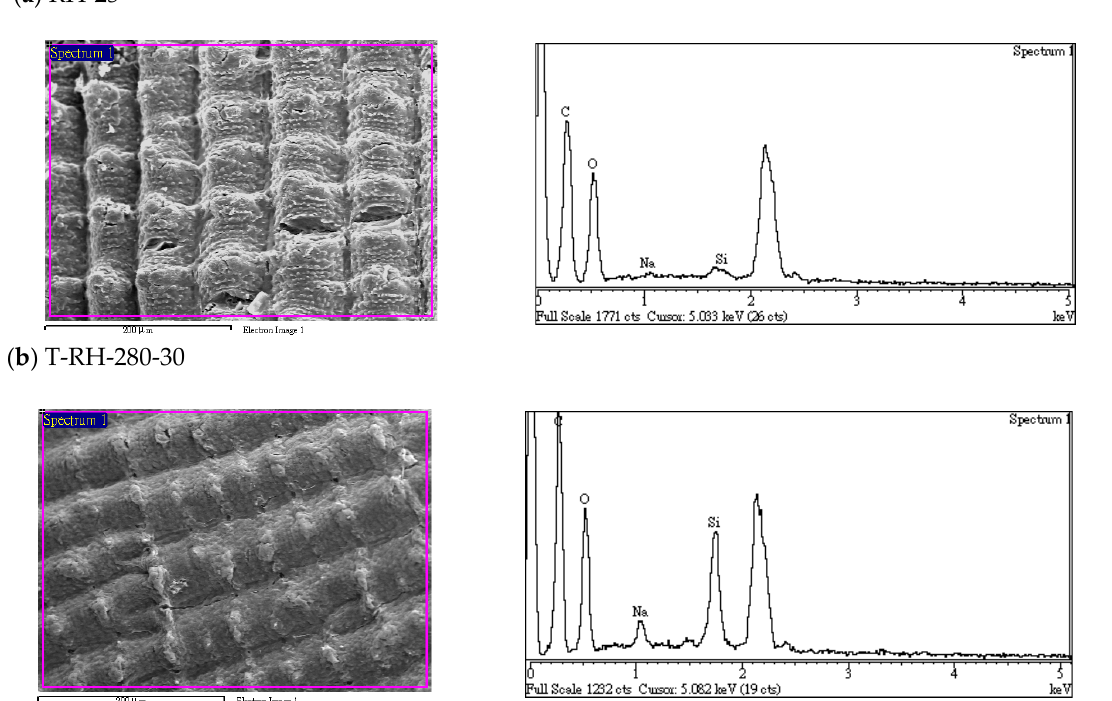
Figure 5. SEM/EDS analyses of ( a ) the pretreated RH (RH-25) and ( b ) the optimal torrefied product (T-RH-280-30).